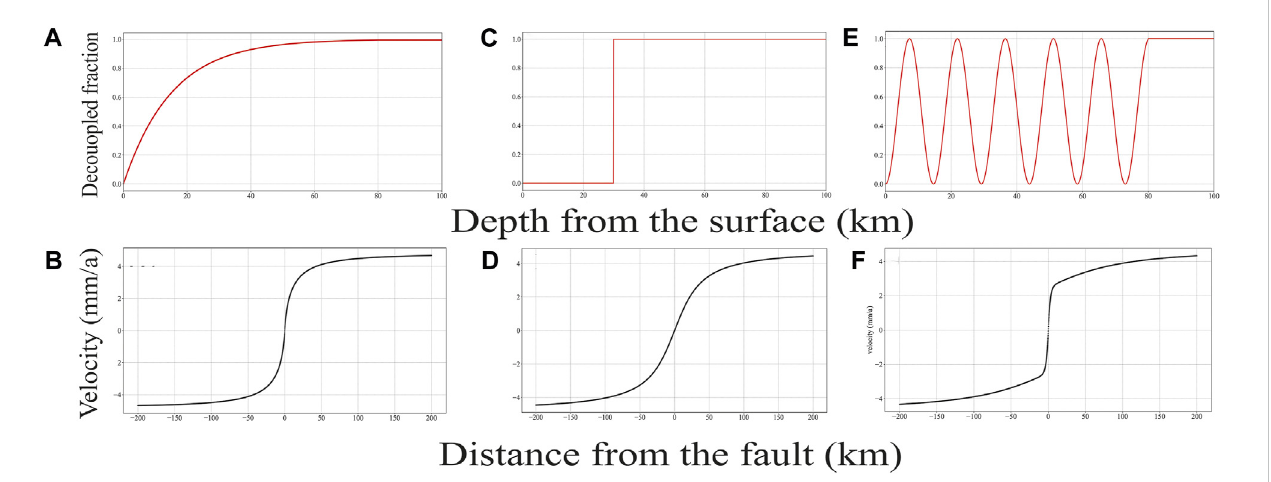
FIGURE 6 Examples of θ ( l ) values and the corresponding deformation. (A) θ ( l ) increases from the surface to underground 80 km; (C) θ ( l ) is 0 above 30 km and 1 below 30 km, which is the SB73 model; (E) θ ( l ) fl uctuates from the surface to 80 km; (B,D,F) corresponding surface deformation. The shape of curve (B) is similar to the arctangent curve.